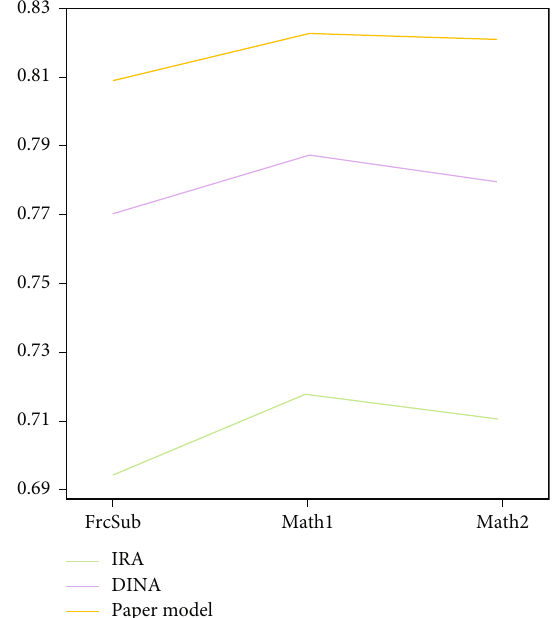
Figure 5: Prediction and test results of exercise accuracy of three exercise recommendation models in three open data